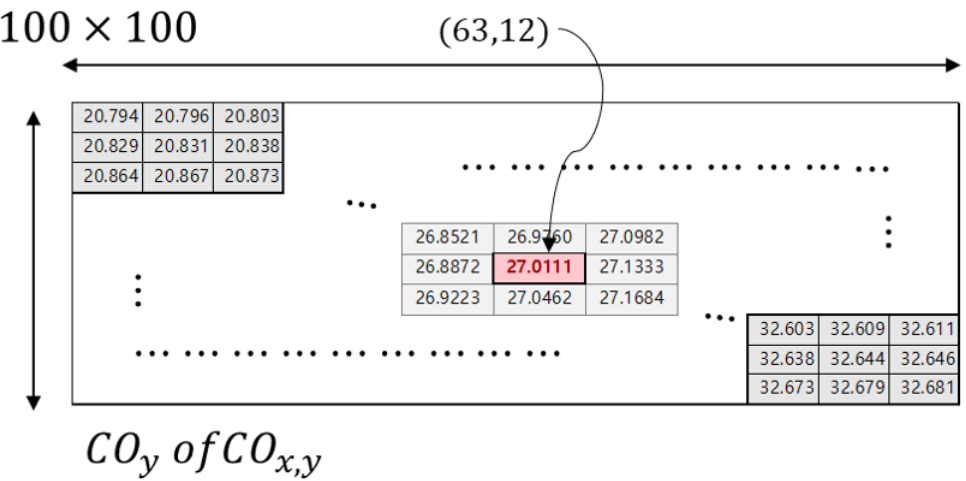
Figure 7. The 100 by 100 matrix about the x-axis value, which results from the computation of CO x , y .